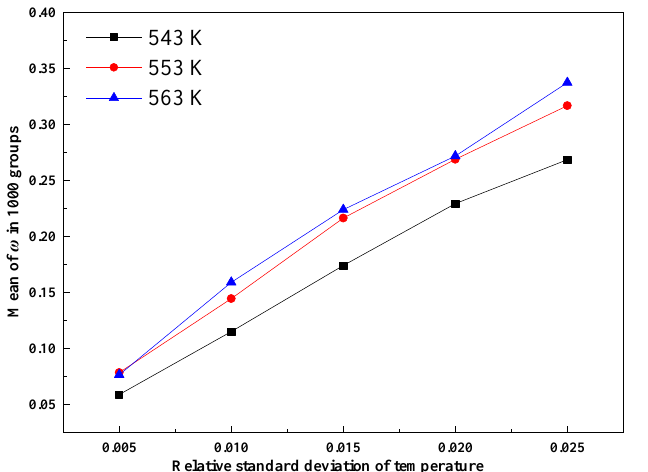
Figure 8. Relationship between different relative standard deviations of temperature and the mean of center concentration deviation.